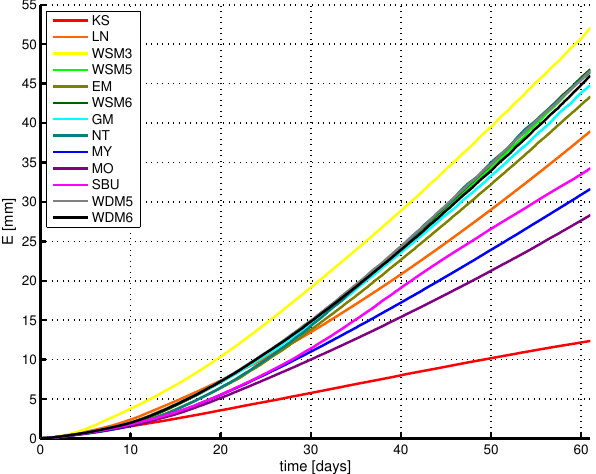
Fig. 7. Comparison of mean accumulated evaporation for the 13 microphysical schemes. The lines seem to follow an exponential increase rather than the linear increase of the lines in Fig.